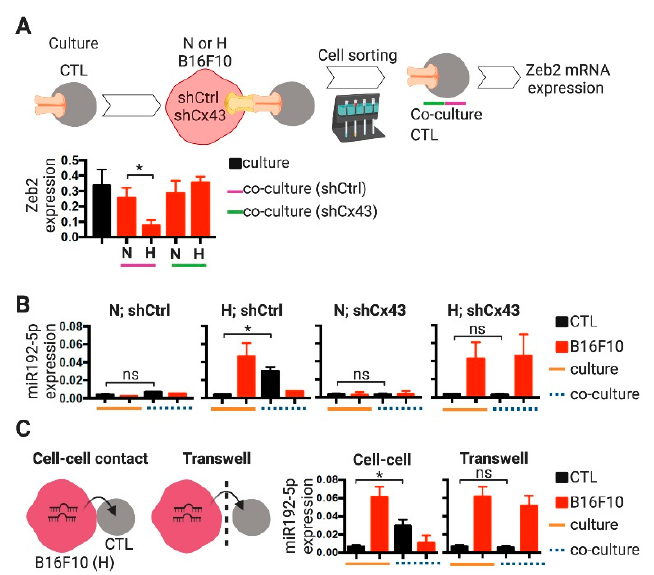
Figure 5. Cytotoxic T lymphocytes acquire miR192-5p from hypoxic B16F10 melanoma cells by a cell contact and Cx43-dependent mechanism. ( A ) Hypoxic B16F10 melanoma cells repress ZEB2 expression in cytotoxic T lymphocytes (CTLs). B16F10 melanoma cells stably transfected with plasmids expressing short hairpin RNAs against Cx43 (shCx43, green line) or control shRNAs (shCtrl, purple line), were cultured for 24 h upon normoxic (21% O 2 , N) or hypoxic (1% O 2 , H) conditions. Then, the N or H melanoma cells were co-cultured for 2 h with pMEL-1 CTLs upon a 1:2 cell ratio. After co-culture, CTLs were isolated by CD8 + magnetic cell sorting. Total RNA samples were isolated from pre-co-culture (named culture, black bar) and post-co-culture (named co-culture, red bars) CTLs and ZEB2 expression was analyzed by qRT-PCR. The levels of ZEB2 mRNAs were obtained by the ∆ / ∆ Ct method and normalized to actin mRNA. ( B ) B16F10 cells stably transfected with plasmids expressing shCx43 or shCtrl, were cultured for 24 h upon N (21% O 2 ) or H (1% O 2 ) conditions. Then, the N or H melanoma cells were co-cultured for 2 h with pMEL-1 CTL upon a 1:2 cell ratio. After co-culture, CTLs were isolated by CD8 + magnetic cell sorting, and CD8 - melanoma cells were also collected. Total RNA samples (including the miRNAs) were isolated from pre-co-culture (named culture, orange lines) and post-co-culture (named co-culture, blue dashed lines) cells and miR-192-5p levels were analyzed by qRT-PCR. miR-192-5p expressions were obtained by the ∆ / ∆ Ct method and normalized to small nuclear RNA RNU6-2. ( C ) Hypoxic B16F10 cells were co-cultured for 2 h with pMEL-1 CTL upon a 1:2 cell ratio allowing or not (transwell) cell-to-cell contact. After co-culture, CTLs were isolated by CD8 + magnetic cell sorting (CD8 - melanoma cells were also collected) and miR-192-5p expression was analyzed by qRT-PCR as described in ( B ). * p < 0.05; ns: non-significant (two-tailed Student’s t -test).